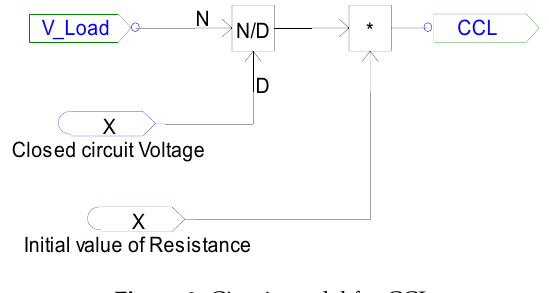
Figure 9. Circuit model for CCL.